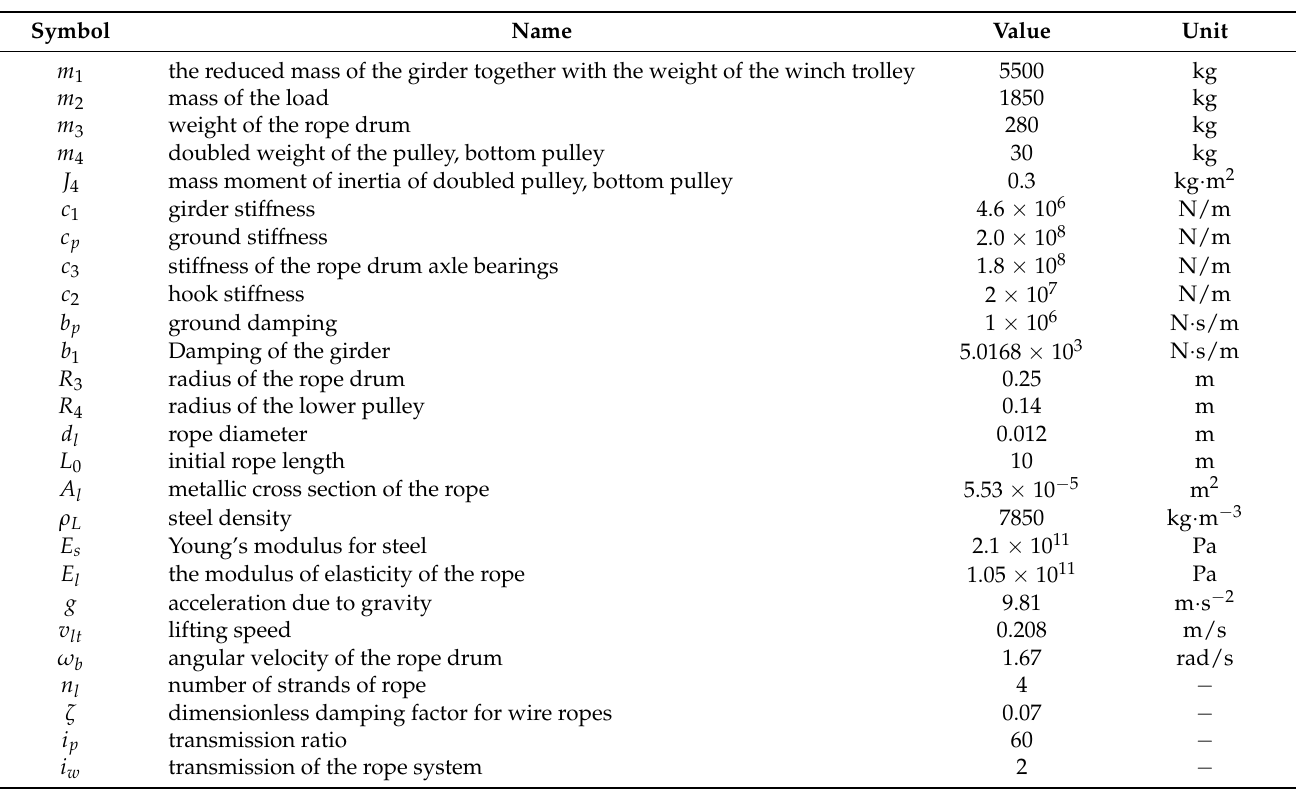
Table 4. Physical parameters describing the model of the drive